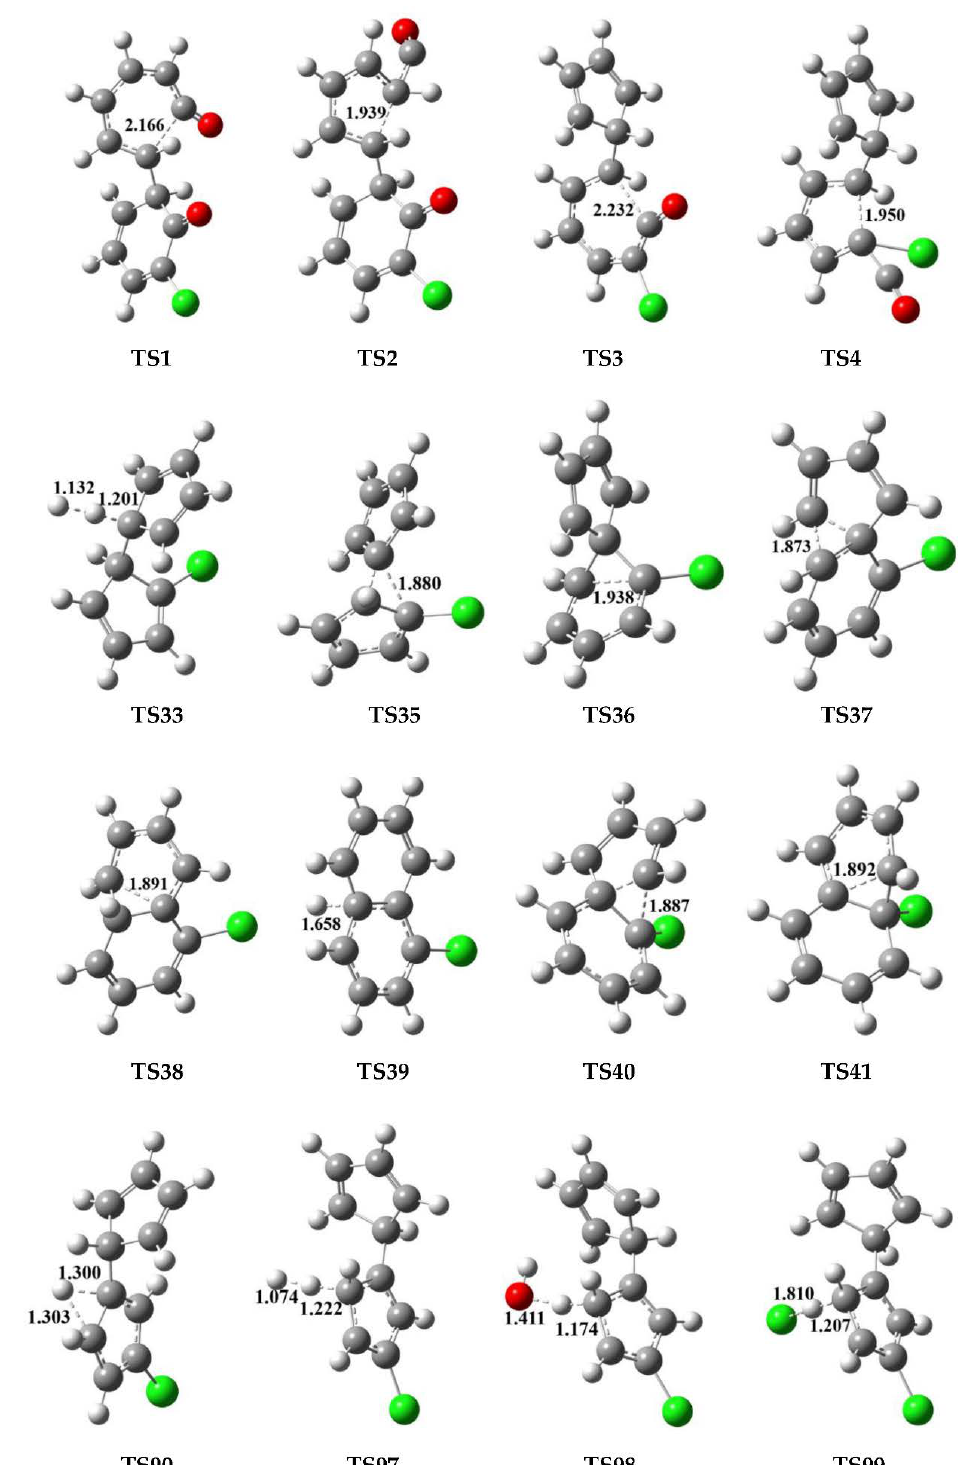
Figure 7. Configurations of the transition states involved in one typical route of PCN formation. Distances are in angstroms. Gray sphere, C; White sphere, H; Red sphere, O; Green sphere, Cl. (For interpretation of the references to color in this figure legend, the reader is referred to the web version of this article).